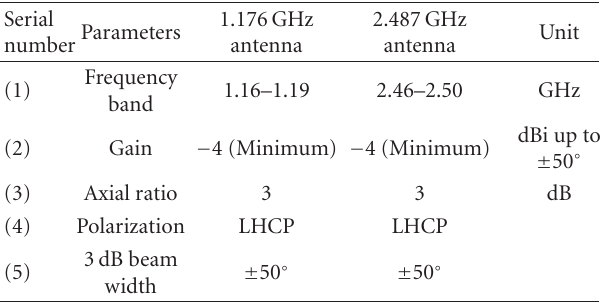
Table 1: Specifications of 1.176 GHz and 2.487 GHz